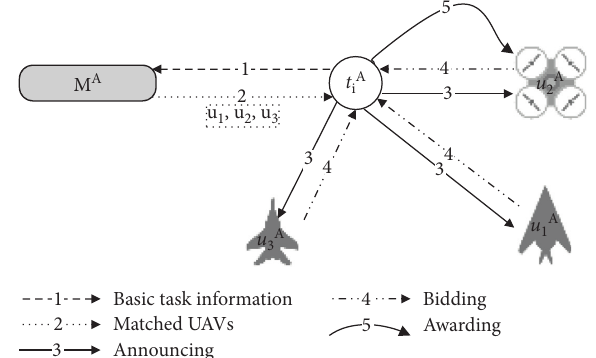
Figure 3: An example of task